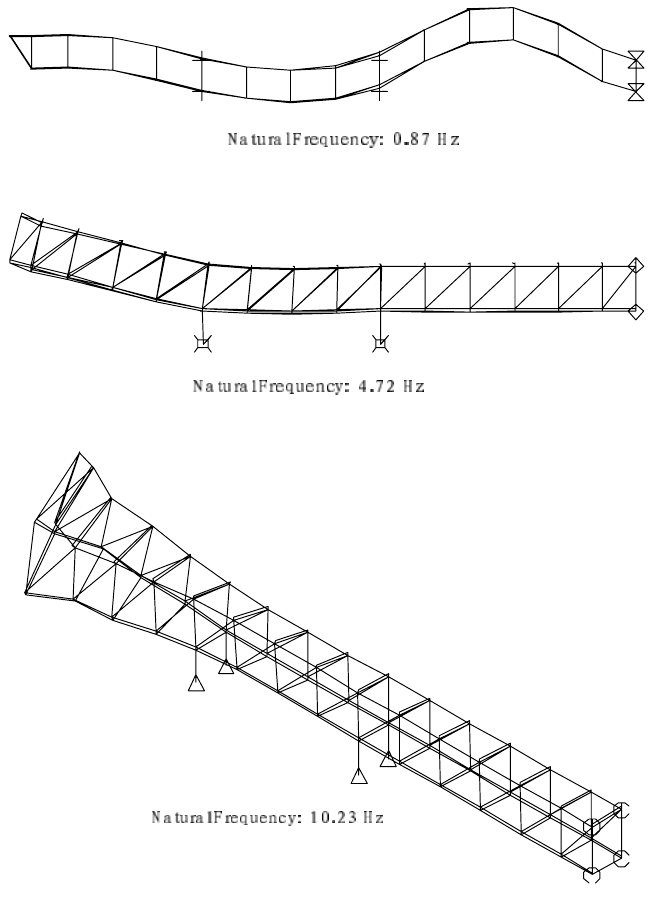
Fig. 2. Fundamental mode shapes (top to bottom) L1, V1 and T1 obtained from finite element